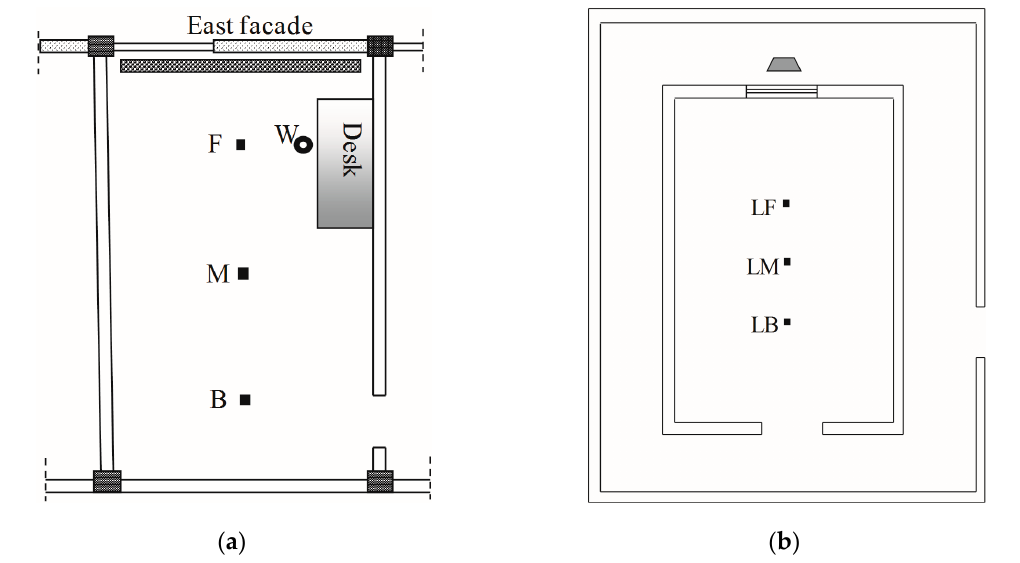
Figure 1. Schema of the analyzed office ( a ); schema of the laboratory test room ( b ).